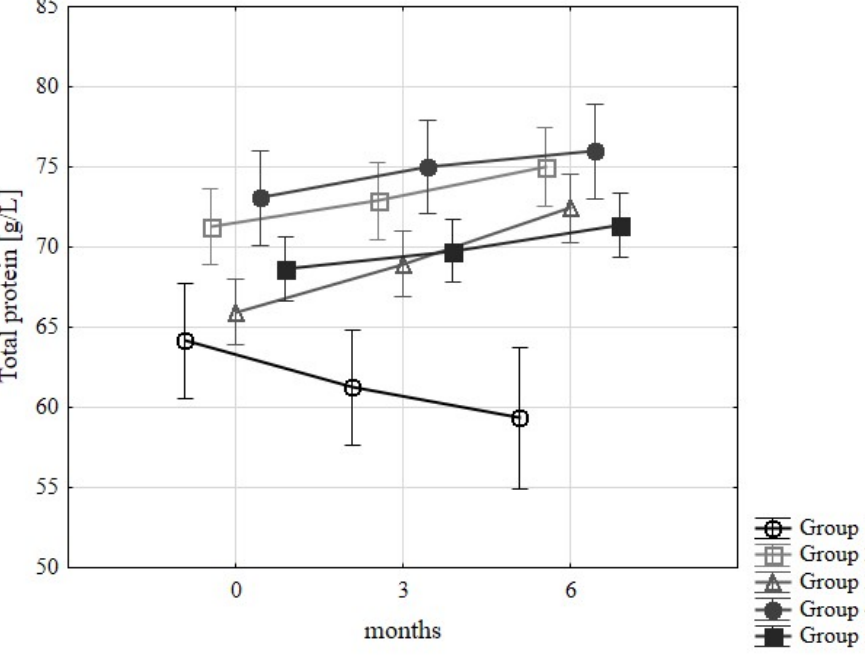
Figure 2. Changes in total protein levels (g/L) in examined groups of patients during 6 months of implementation of diet recommendations.